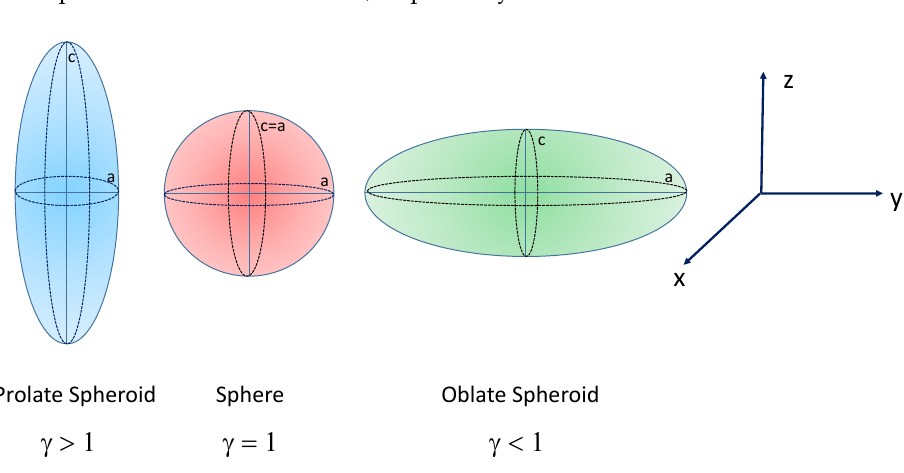
Figure 2. Basic types of spheroids (bi-axial